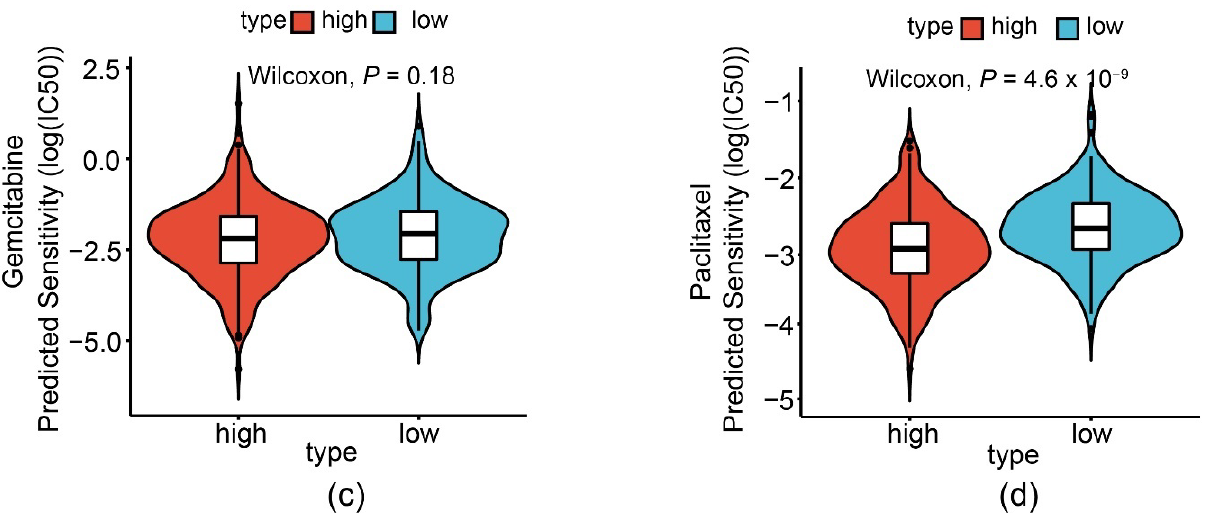
Figure 4. The risk score predicts the sensitivity of the TCGA-LUAD patients to chemotherapy. Predicted response to drugs, including cisplatin ( a ), docetaxel ( b ), gemcitabine ( c ), and paclitaxel ( d ).